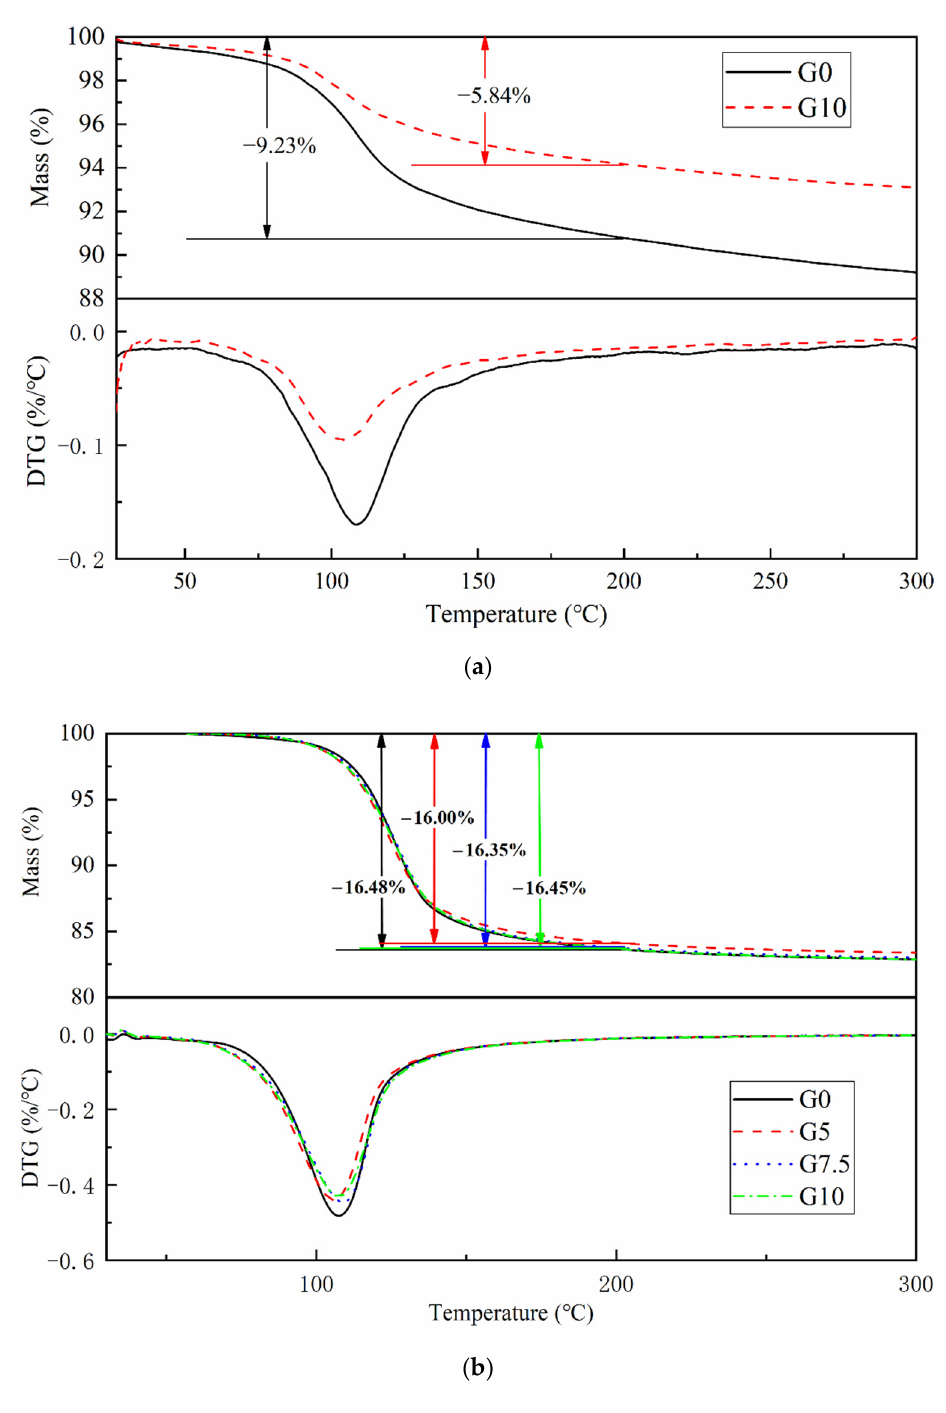
Figure 9. TG/DTG curves of MPC with various modified MgO at different curing ages: ( a ) 3 h; ( b ) 28